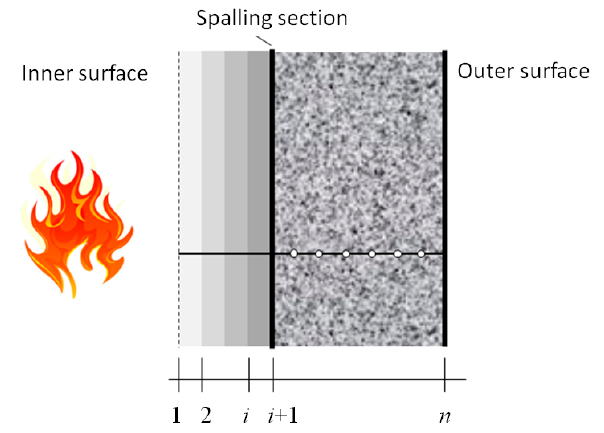
Figure 8. Schematic of the spalling process of concrete lining under tunnel fire.